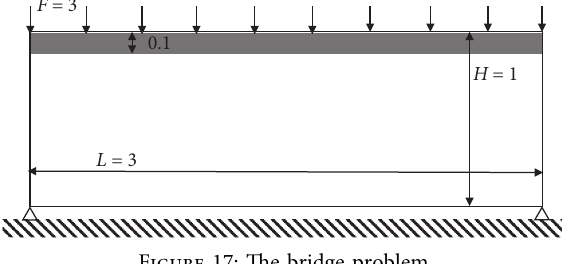
Figure 17: The bridge problem.